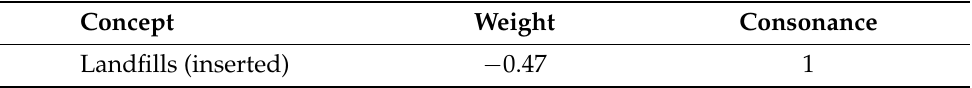
Table 5. Maximum solution in the fuzzy cognitive map determining the ecological state of the city.